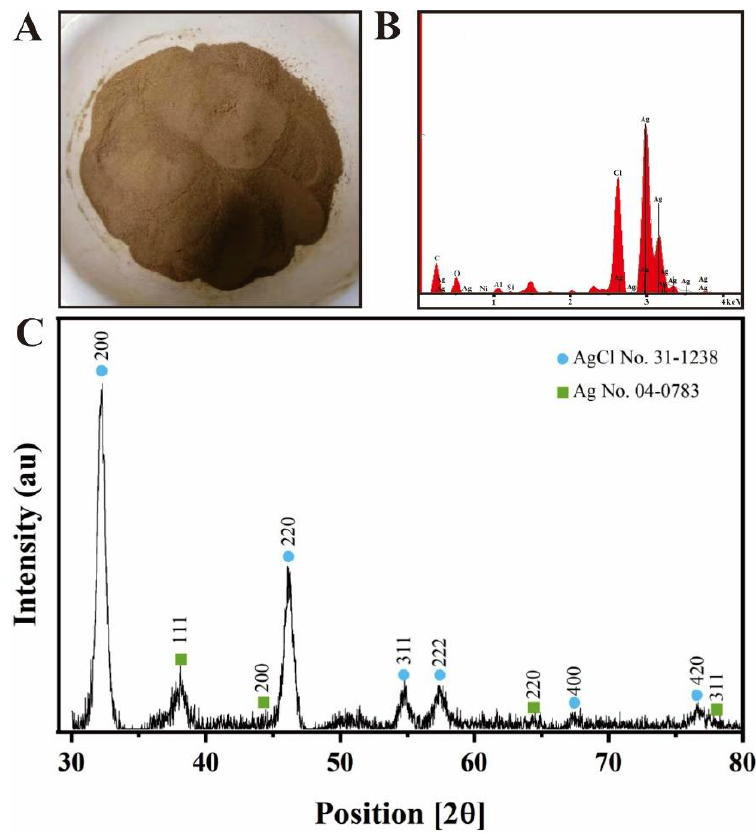
Figure 3. Powder of nanoparticles ( A ), EDS spectrum ( B ) and XRD spectrum ( C ) of biogenic Ag@AgCl nanoparticles.